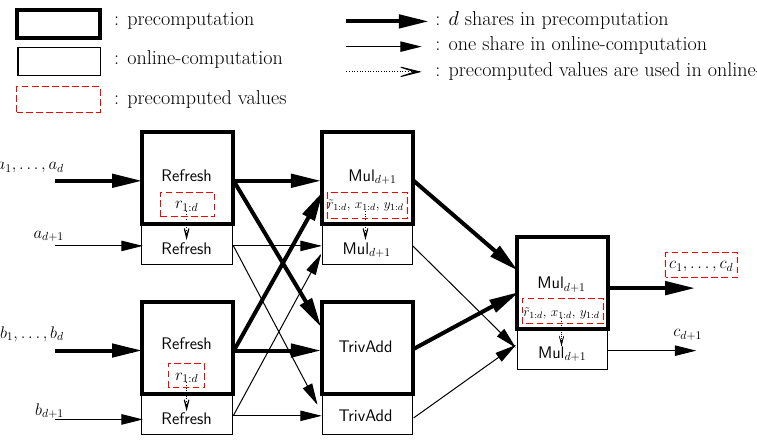
Figure 2: An example for ab ( a ⊕ b ) using Mul d +1 , TrivAdd and Refresh